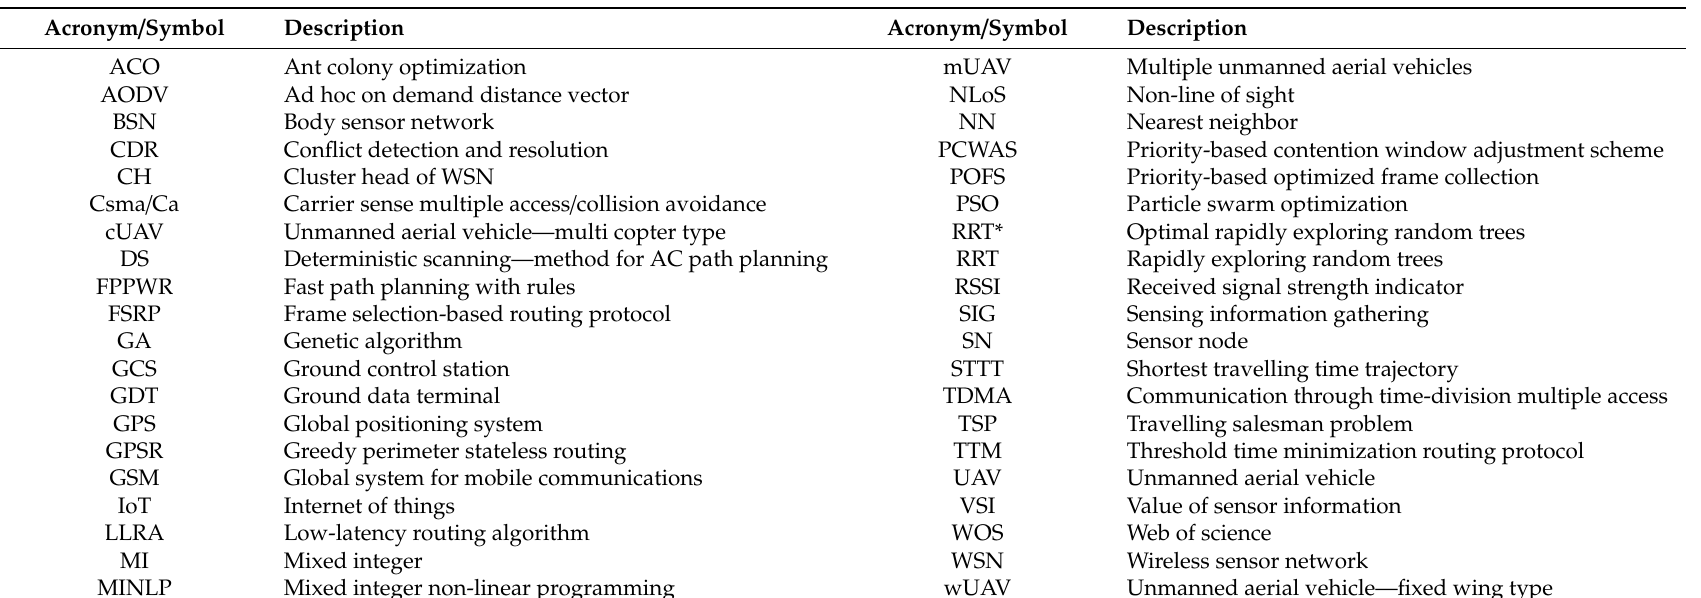
Table A1. List of acronyms and symbols